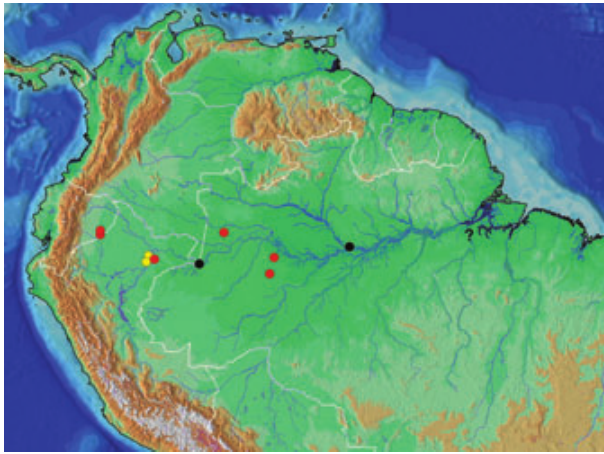
Fig. 3. Map of the northern portion of South America showing the distribution of Thalassophryne amazonica based on records we surveyed. Red dots indicate localities for which there is material deposited in collections; yellow dots indicate localities for which no specimens were deposited in collections. Black dots indicate type localities. The “?” indicates a possibly incorrect record for the species by Steindachner (see text for discussion).